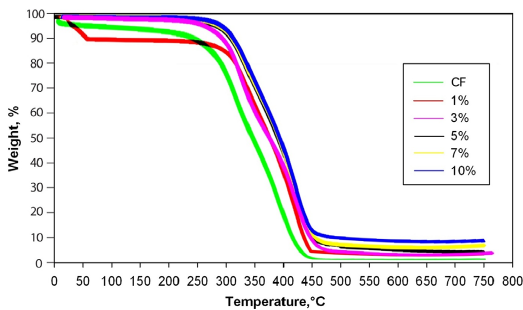
Figure 4. TGA spectra of photocured materials. Table 2. Thermal properties of photocured materials.